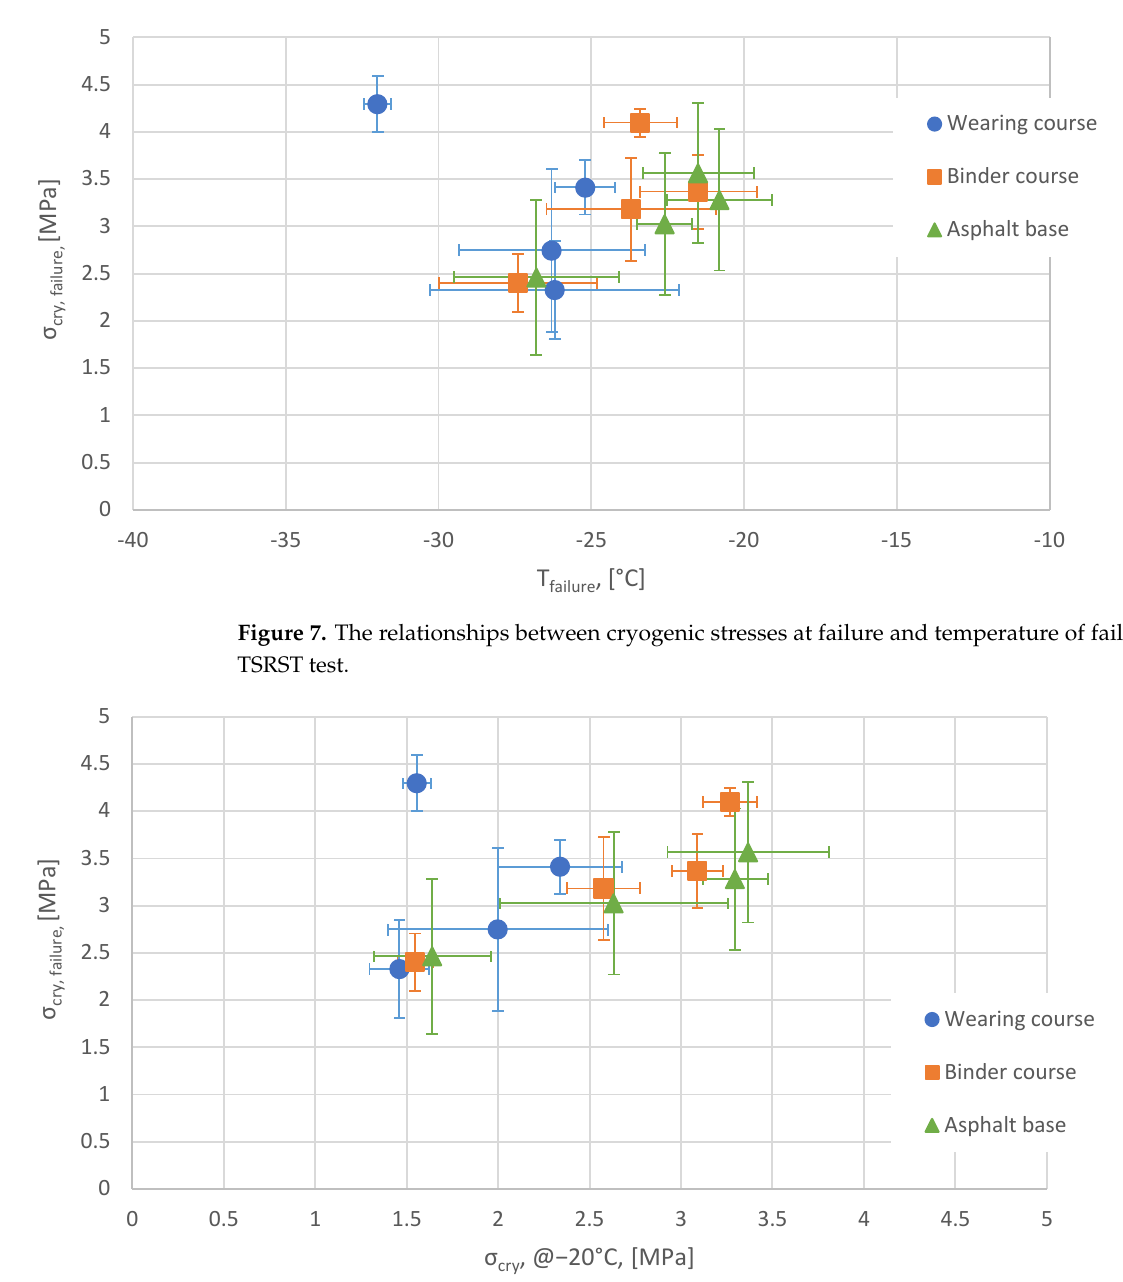
Figure 8. The relationships between cryogenic stresses at −20 °C and cryogenic stresses at failure temperature .